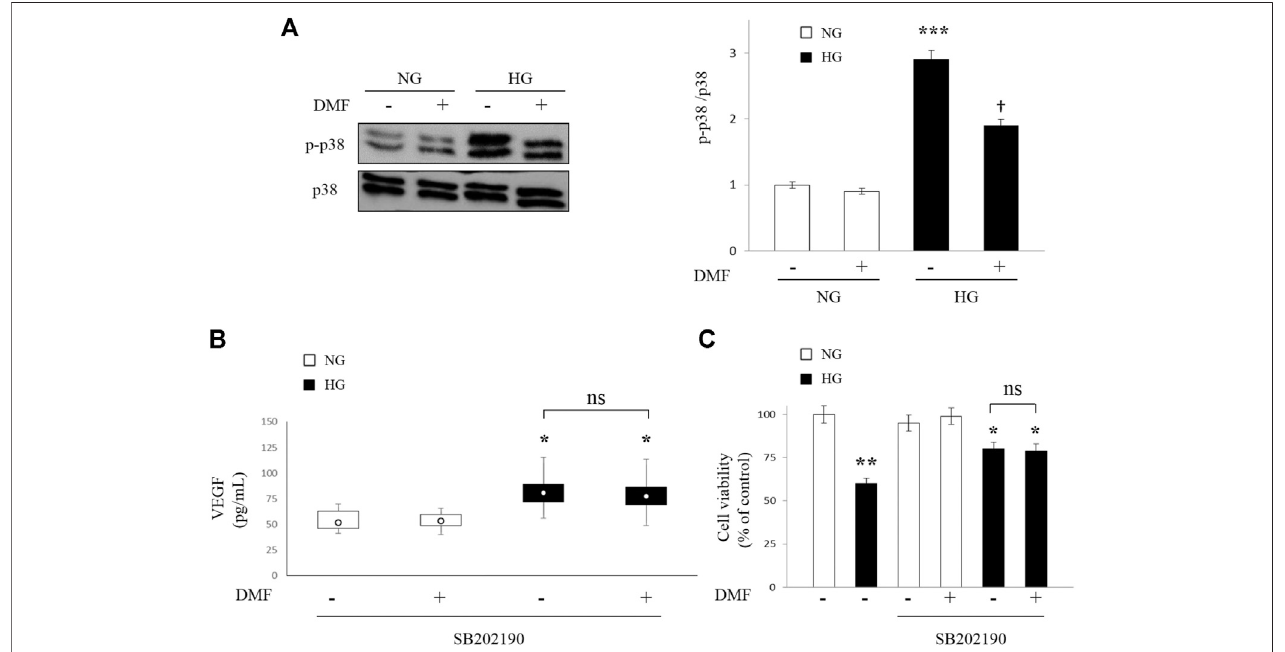
FIGURE 4 | Effects of DMF on p38 MAPK pathway. ARPE-19 cells exposed to normal glucose (NG) or high glucose (HG) w/or w/o DMF (10 μ M) for 24 h (A) p38 MAPK was measured by western blot analysis; band densities were quanti fi ed by ImageQuantTL software and normalized values were plotted in the histogram shown on the right (*** p < 0.001 vs. NG; † p < 0.05 vs. untreated/HG; n (cid:2) 6). (B) ARPE-19 cells exposed to normal glucose (NG) or high glucose (HG) were pretreated with SB202190 (10 µM), a p38 MAPK inhibitor for 30 min and then treated with DMF (10 μ M) for 24 h. VEGF levels were measured through ELISA. * p < 0.05 vs. NG untreated cells; n (cid:2) 6. ( C ) MTT analysis: values are expressed as percentage of cell viability in NG untreated cells. * p < 0.05 or ** p < 0.01 vs. NG untreated cells; n (cid:2)